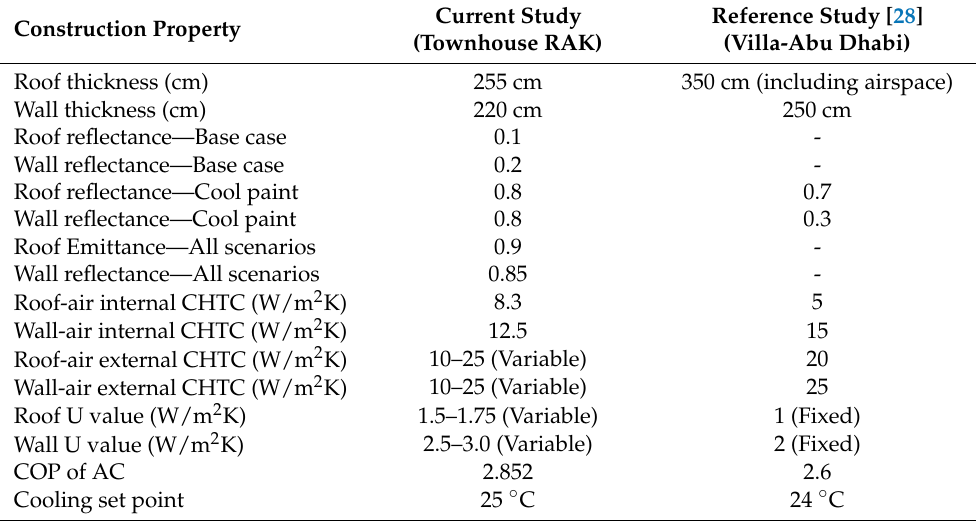
Figure 6. Thermal imaging of windows outside (top row) and inside (bottom row). Table 3. Construction characteristics of townhouse used in the